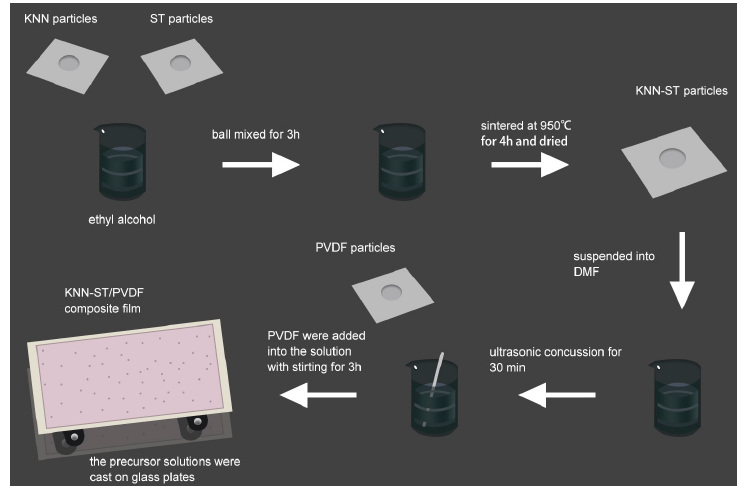
Figure 1. The scheme of the membrane and the particles preparation.